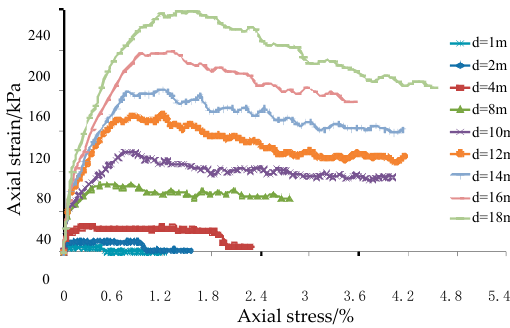
Figure 17. Axial stress-strain curve in plane strain numerical analysis.